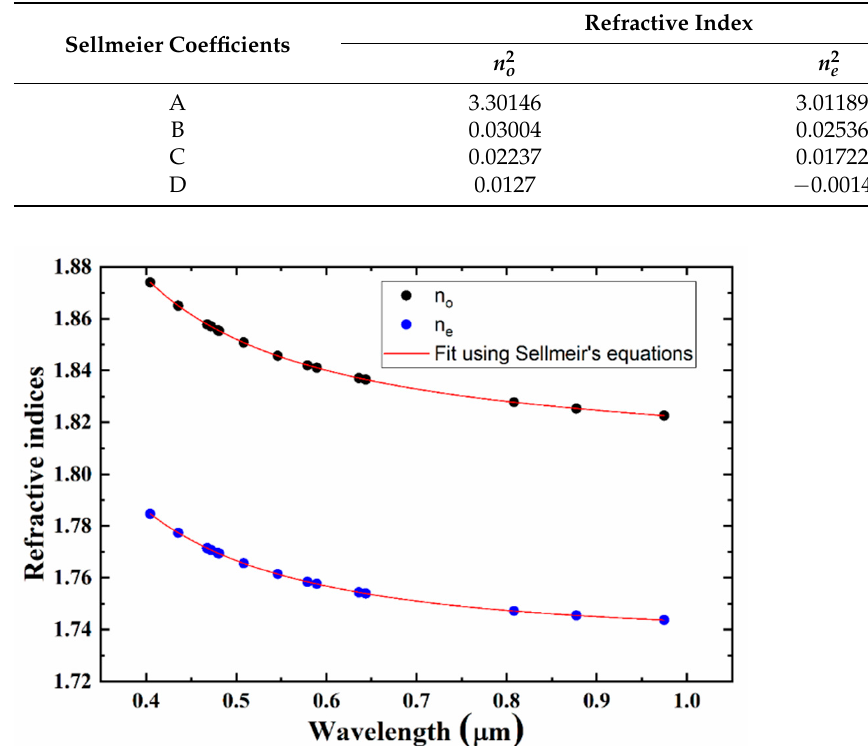
Table 4. Sellmeier coefficients of the LYSB crystal.